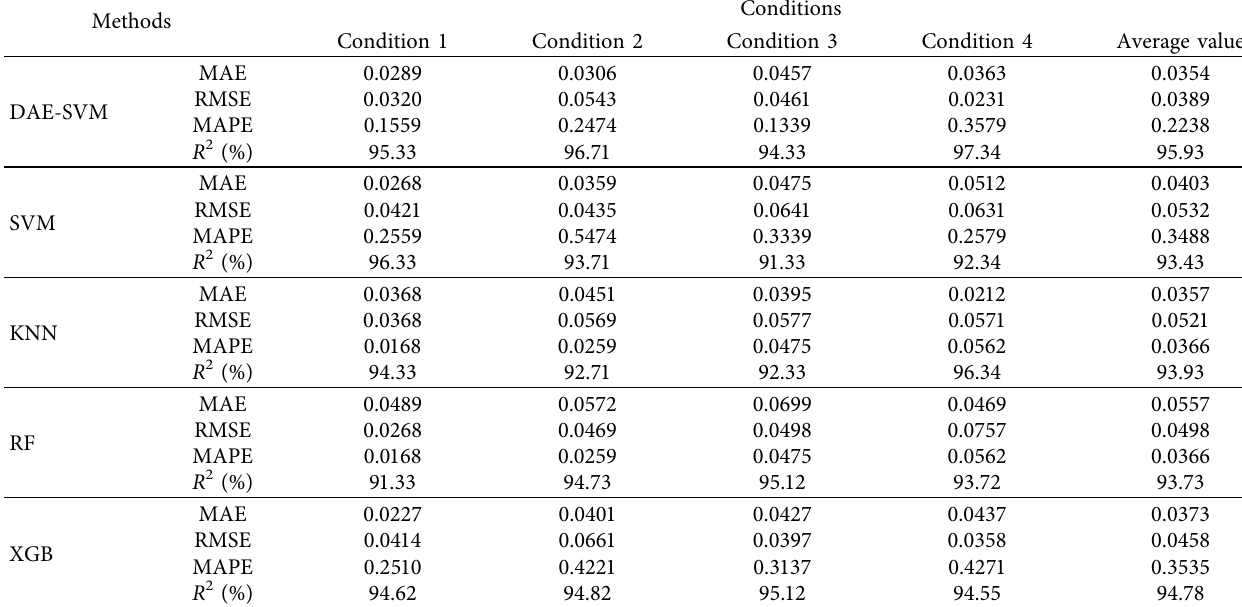
Table 8: Comparison of different methods in evaluation